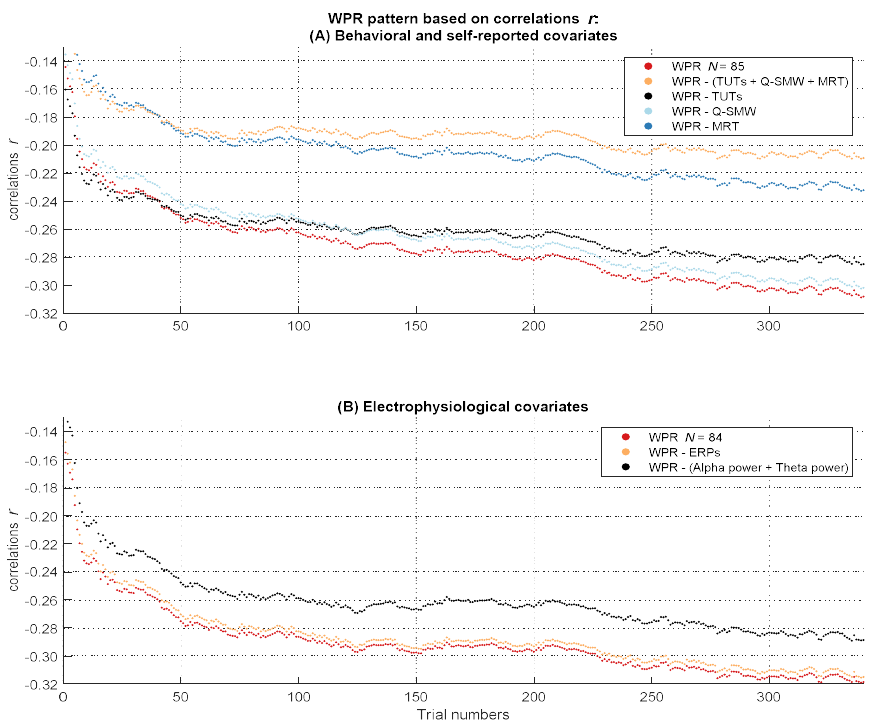
Figure 5. Course of the correlations over the RT distribution before and after controlling for the influence of the attentional lapses covariates . The figure describes the worst performance pattern in correlations before (red lines) and after (other lines) the different covariates or their combinations were partialized out of the RT variable (labeled in the boxes on the side of the dashes in the figure legend). ( A ) shows the results of the behavioral and self-reported covariates in the full sample of N = 85. ( B ) shows the results of the electrophysiological covariates in the subsample of N = 84. Questionnaire of Spontaneous Mind Wandering